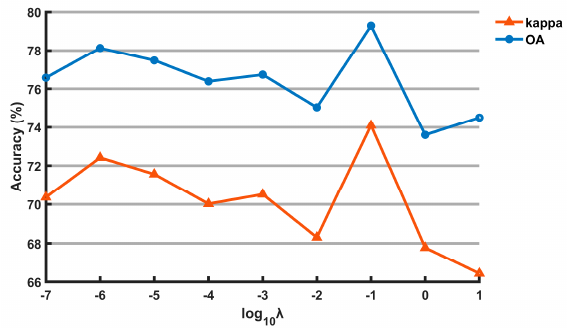
Figure 12. Classification accuracies using SAEs with different λ .